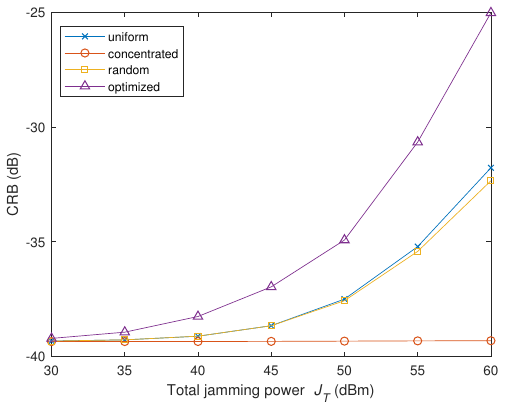
Figure 5. CRB of v x versus the total jamming power J T in the second scenario.